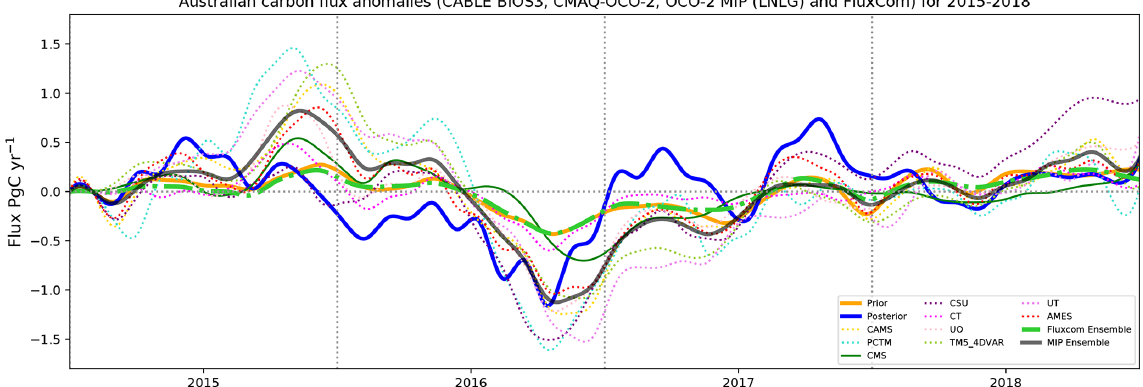
Figure 12. Comparison between monthly mean posterior (blue line), prior (orange line), FLUXCOM ensemble mean (green line), OCO-2 MIP ensemble (black line) carbon fluxes, and the monthly carbon fluxes from the nine models that participate in OCO-2 MIP: AMES, PCTM, CAMS, CMS-Flux, CSU, CT, OU, TM5-4DVAR, and UT (in PgCyr − 1 ).